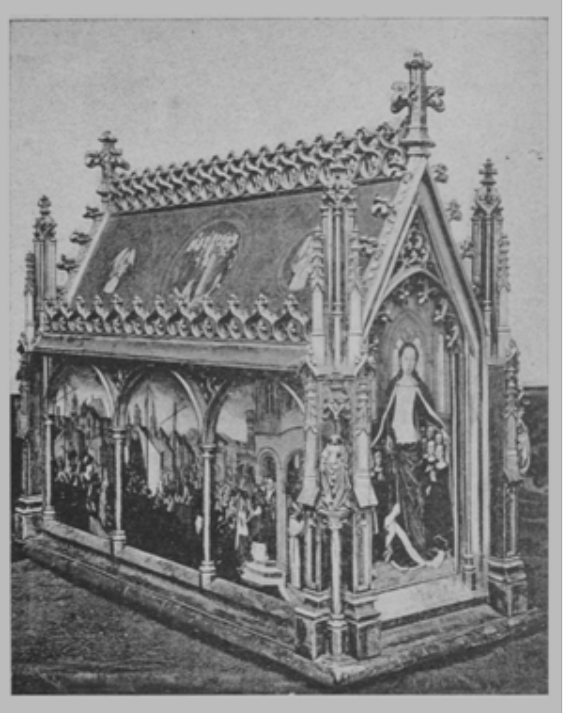
Figure 13. Anonymous. The Shrine of Saint Ursula by Hans Memling in Bruges La Morte